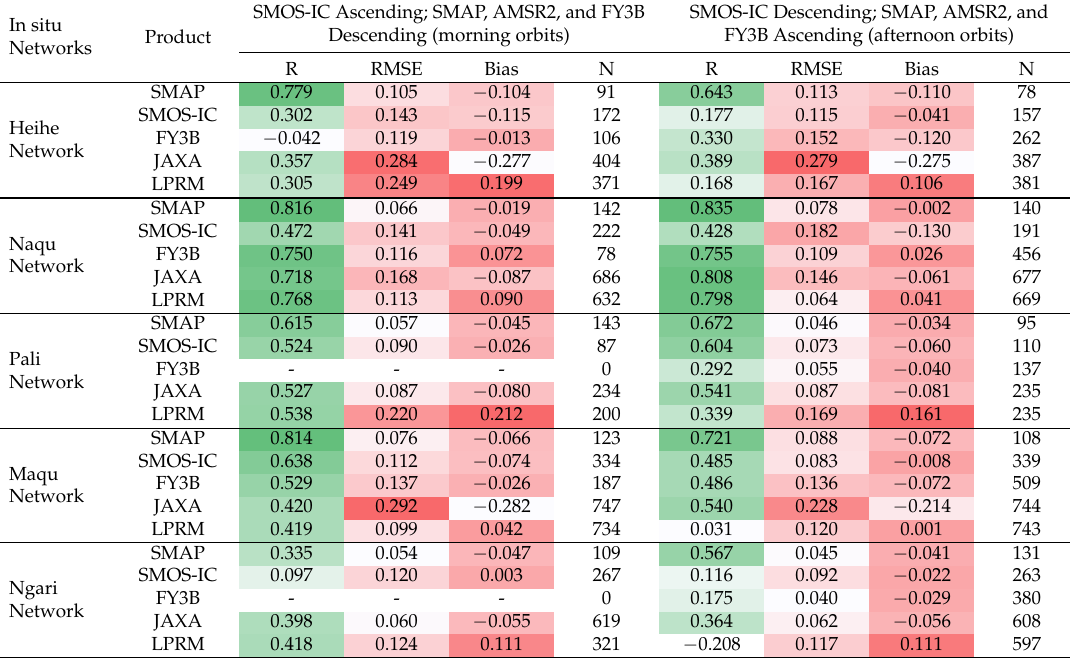
Table 3. Performance metrics of the SMAP, SMOS-IC, FY3B, JAXA, and LPRM soil moisture data products for the unfrozen seasons from 2012 to 2016 in the five validation networks